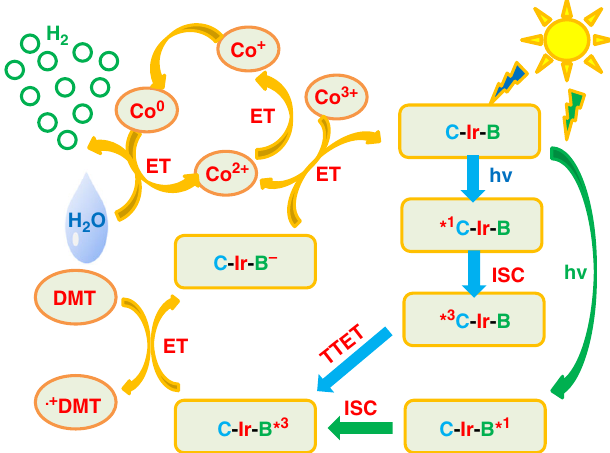
Fig. 9 Proposed photochemical process for hydrogen evolution with Ir-4 (C-Ir-B). Ir is the coordination center, C is Coumarin, B is Bodipy, ET is electron transfer, ISC is intersystem crossing, TTET stands for